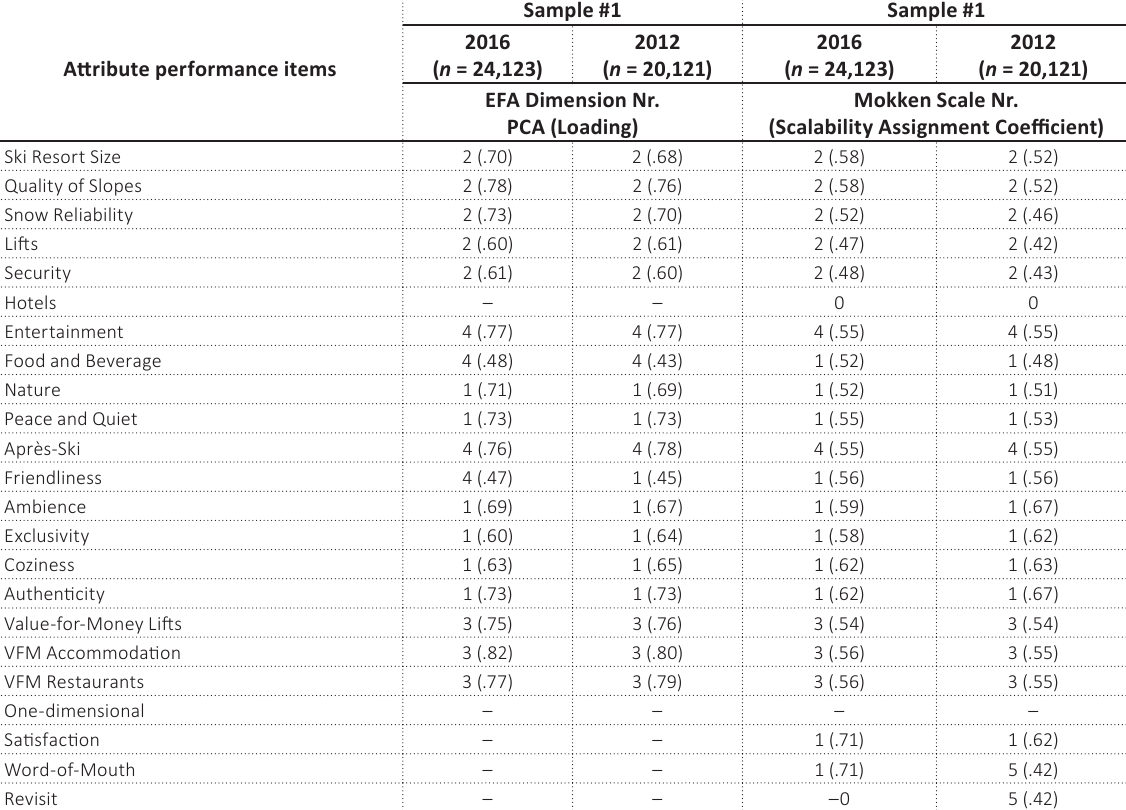
Table B1. Dimensional structure according to EFA and Mokken item scalability >